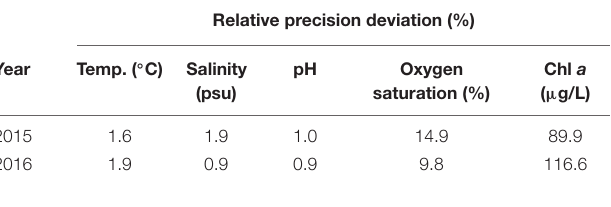
TABLE 1 | The relative precision deviation (RPD) of data from the real-time monitoring system and standard methods developed by the Environmental Protection Administration, Taiwan.